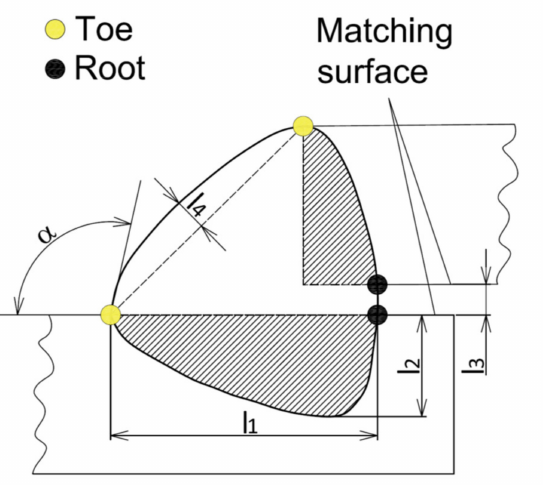
Figure 6. Geometrical shape of weld joint with the monitored dimensions in quality inspection ( α —toe angle; l 1 —leg length; l 2 —penetration; l 3 —gap width; l 4 —excess welding).